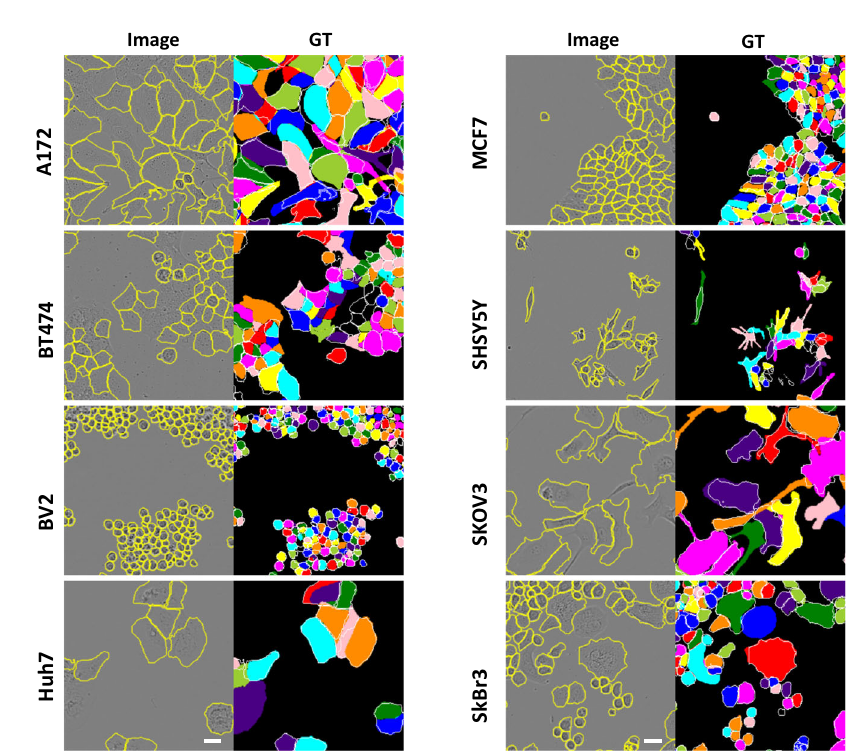
Fig. 5 Segmentation examples for LIVECell dataset using LACSS models trained with the semi-supervision con fi guration. Examples for all eight cell lines were shown. The input phase contrast images (left) were overlaid with model predictions drawn as yellow contours. The ground truth segmentations were shown on the right, for which the model predictions were also shown as white contours for comparison. Scale bars represent 20